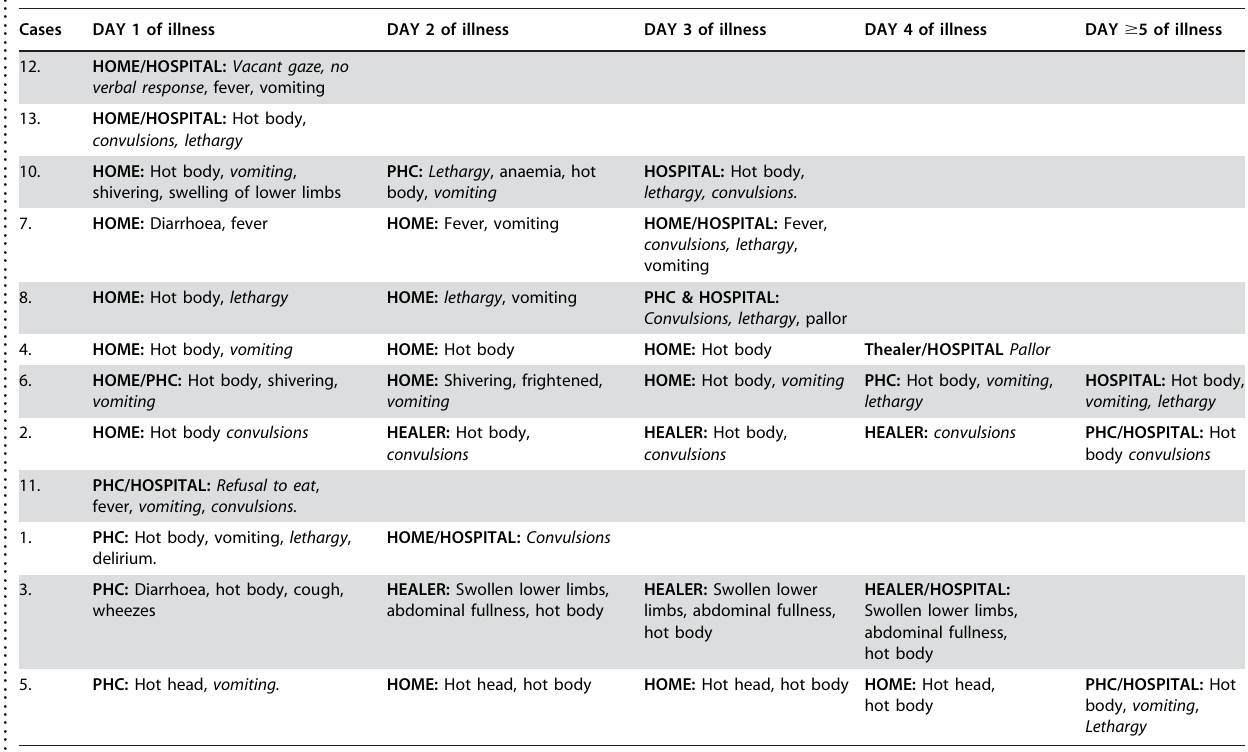
Table 5. Care-seeking patterns for children (n= 12) with severe malaria admitted at Mtwara Regional hospital. .. ... .... ... ... .... ... ... .... ... ... .... ... ... .... ... ... .... ... ... .... ... ... .... ... ... .... ... ... .... ... ... .... ... ... .... ... ... .... ... ... .... ... ... .